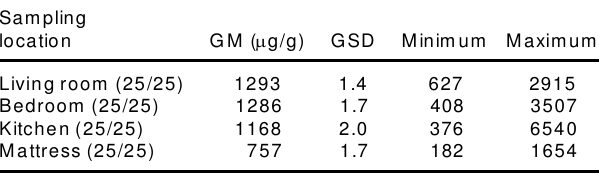
Table 2. (1 ® 3)- b -glucan exposure measurements in house dust (glucan detectable/total samples) Sampling location